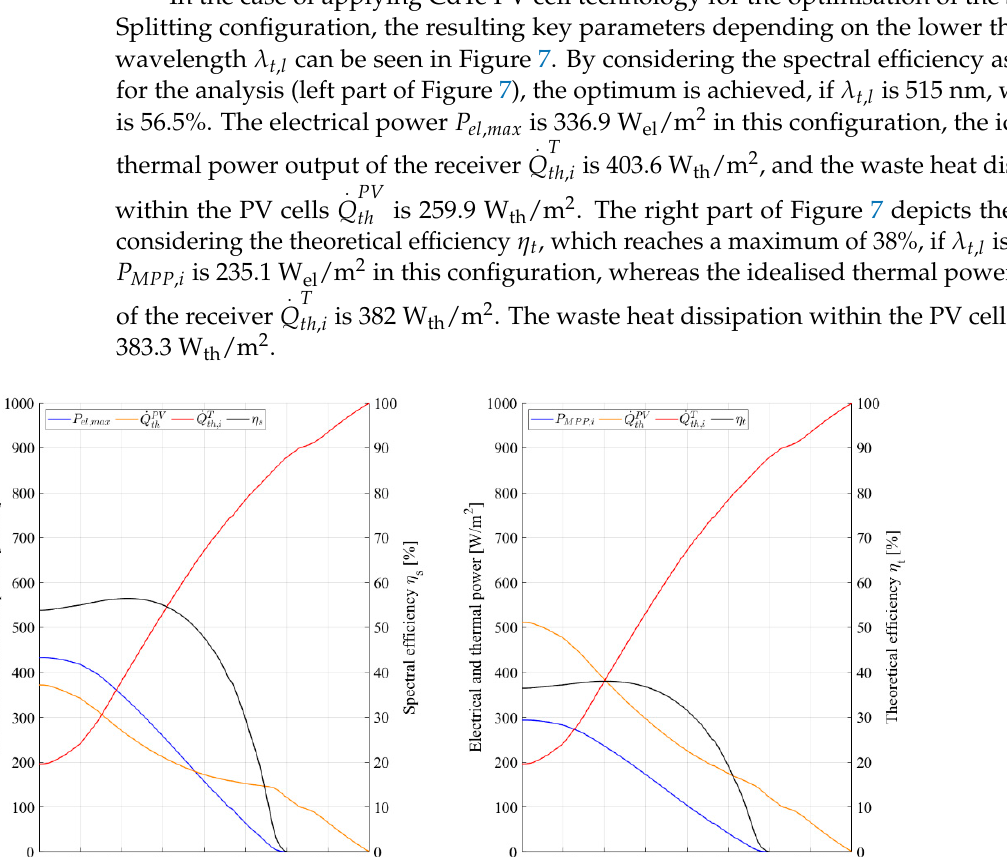
Table 3. Comparison of key parameters at full spectrum and at optimum Spectral Splitting configuration for CdTe PV technology.